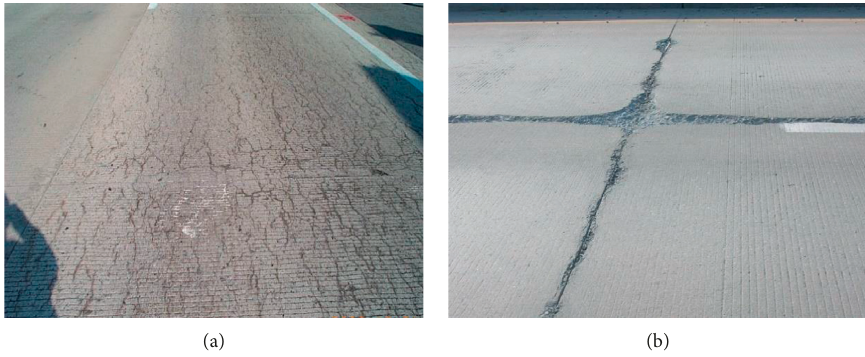
Figure 1: Typical distresses of JPCP in Korea. (a) ASR distresses. (b) Joint freeze-thawing distress. Table 1: Mix design changes of expressway concrete pavement in